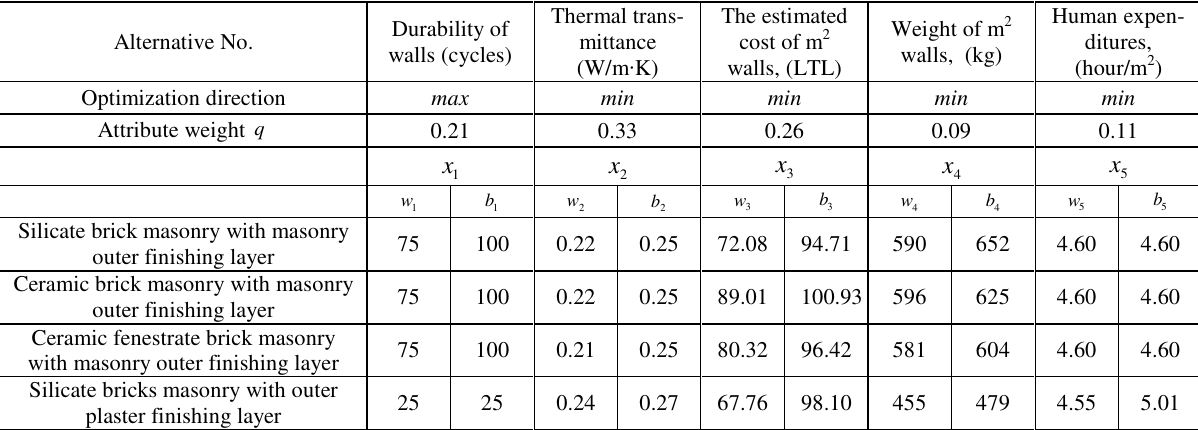
Table 2. Weighted normalized decision-making matrix according to a COPRAS-G method Weighted normalized values of the attributes describing the compared alternatives – matrix X ˆ Alterna- tive No.